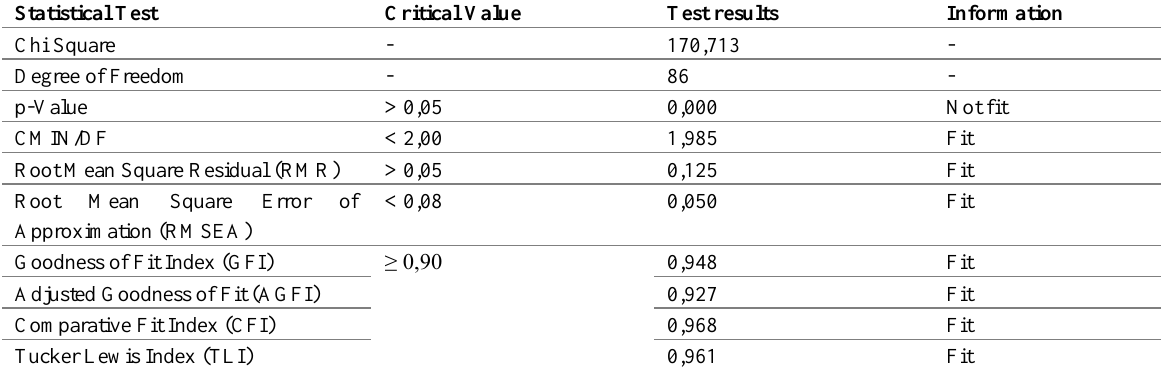
Table 5: Model Fit on Initial